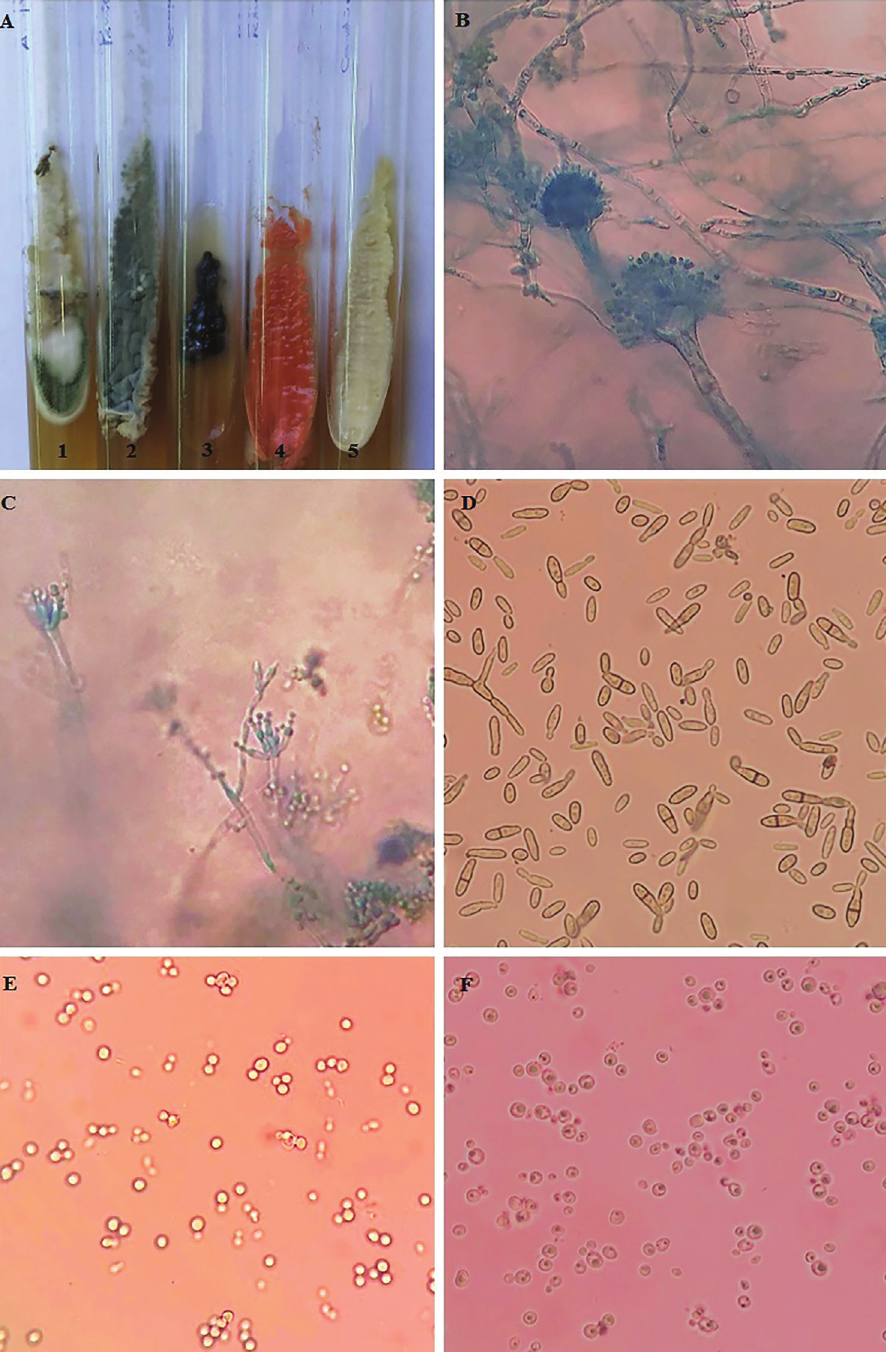
FIGURE 1 - Macromorphological and micromorphological aspects of fungi isolated from peanut, and cashew samples marketed in Northeast Brazil, after incubation on Sabouraud Dextrose Agar (SDA), at 25-30°C, for 3 to 5 days. A- Macromorphological aspects of fungal colonies. 1. Aspergillus flavus (yellow-green velvety colony with white reverse). 2. Penicillium sp. (grey-green furrowed colony with white reverse). 3. Exophiala sp. (wet, creamy, black yeast-like colony.) 4 . Rhodotorula sp. (smooth to mucoid, salmon pink yeast colony) 5. Candida albicans (white-cream creamy colony) B- Micromorphological aspect of Aspergillus flavus (long conidiophores, hemispherical vesicle, biseriate or sometimes uniseriate phialides, smooth or slightly rough with long chains conidia). Micromorphological aspect of Penicillium sp. (conidia produced in chains from the tips of the phialides). Micromorphological aspect of Exophiala sp. (dematiaceous budding cells and torulose mycelium). Micromorphological aspect of Rhodotorula sp. (unicellular blastoconidia, lacking pseudohyphae and true hyphae). Micromorphological aspect of Candida albicans (blastoconidia; pseudohyphae and true hyphae may be